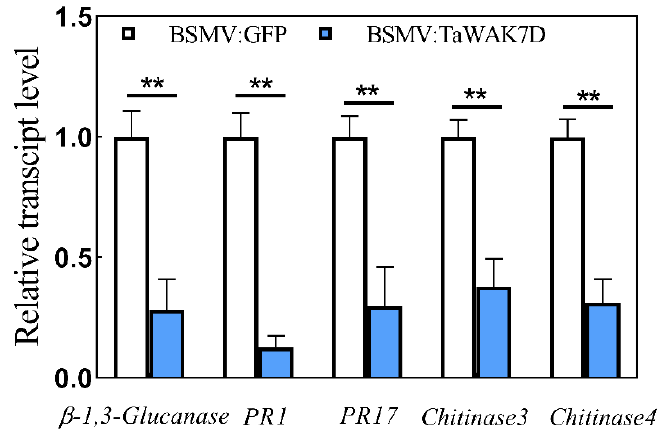
Figure 7. Transcript profiles of TaWAK7D and pathogenesis-related genes in BSMV:GFP- and BSMV:TaWAK7D-infected wheat plants after infection by pathogens. Relative transcript abun- dances of β -1,3-Glucanase , PR1 , PR17 Chitinase3 and Chitinase4 in BSMV:TaWAK7D-infected CI12633 plants were quantified relative to those in BSMV:GFP-infected control plants after R. cere- alis inoculation for 10 days. Statistically significant differences between BSMV:TaWAK7D-infected and BSMV:GFP-infected wheat plants were determined based on three biological replications ( Student’s t-test: ** p < 0.01). Bars indicate the standard error of the mean. TaActin was used as an internal control.